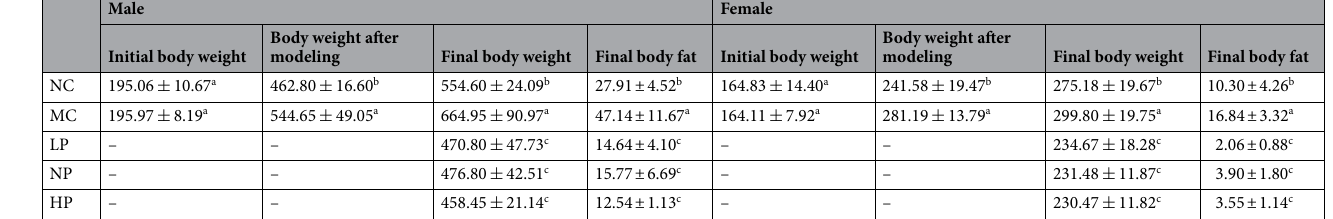
Table 3. Body weight and body fat of rats in different groups (g). NC normal control group, MC model control group, LP low energy low protein group, NP low energy normal protein group, HP low energy high protein group. Values are the mean ± SD. Mean values within a column with different superscript letters (a, b, c) were significantly different ( P <